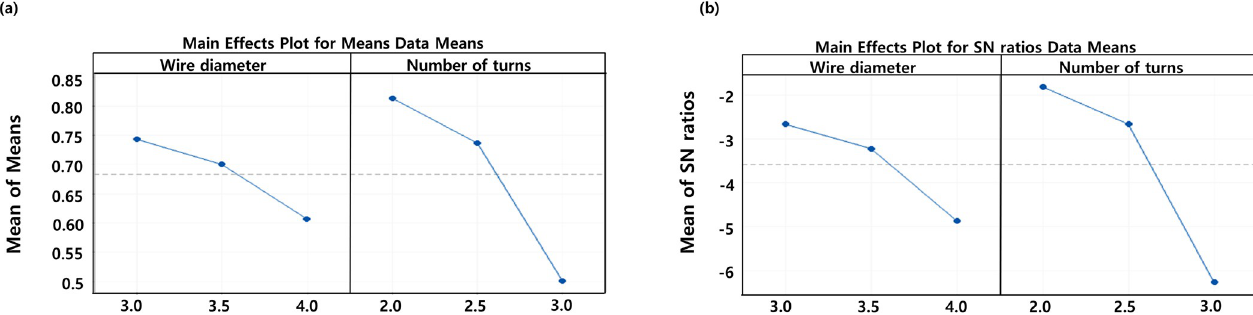
Fig 9. (a) Main effects plot of the means and (b) main effects plot of the S/N ratios (larger is better) for the Range of motion (ROMO of the L3-L4 lumbar spine segment.